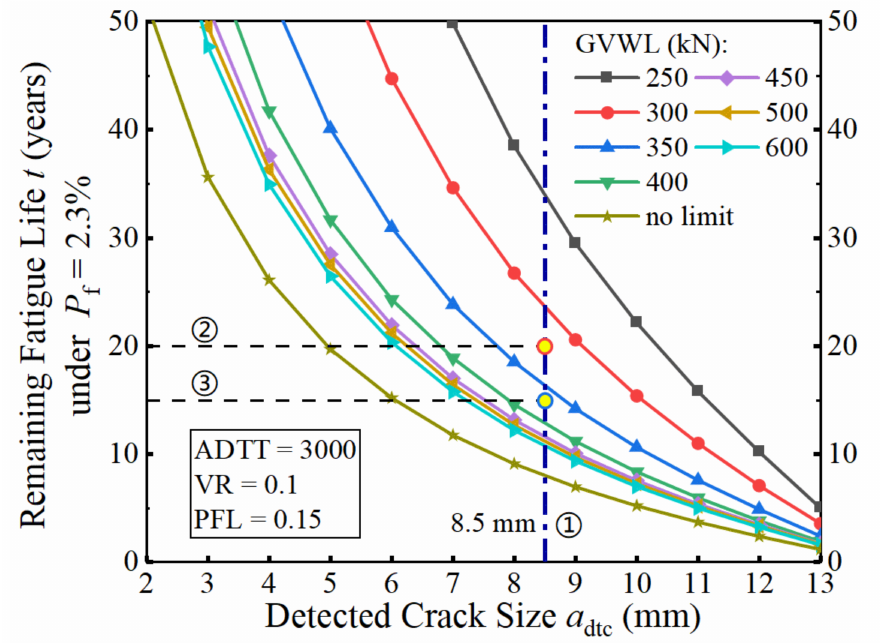
Figure 22. Relationship between the remaining fatigue life and the detected crack size when VR = 0.1, ADTT = 3000, PFL = 0.15, and P f =